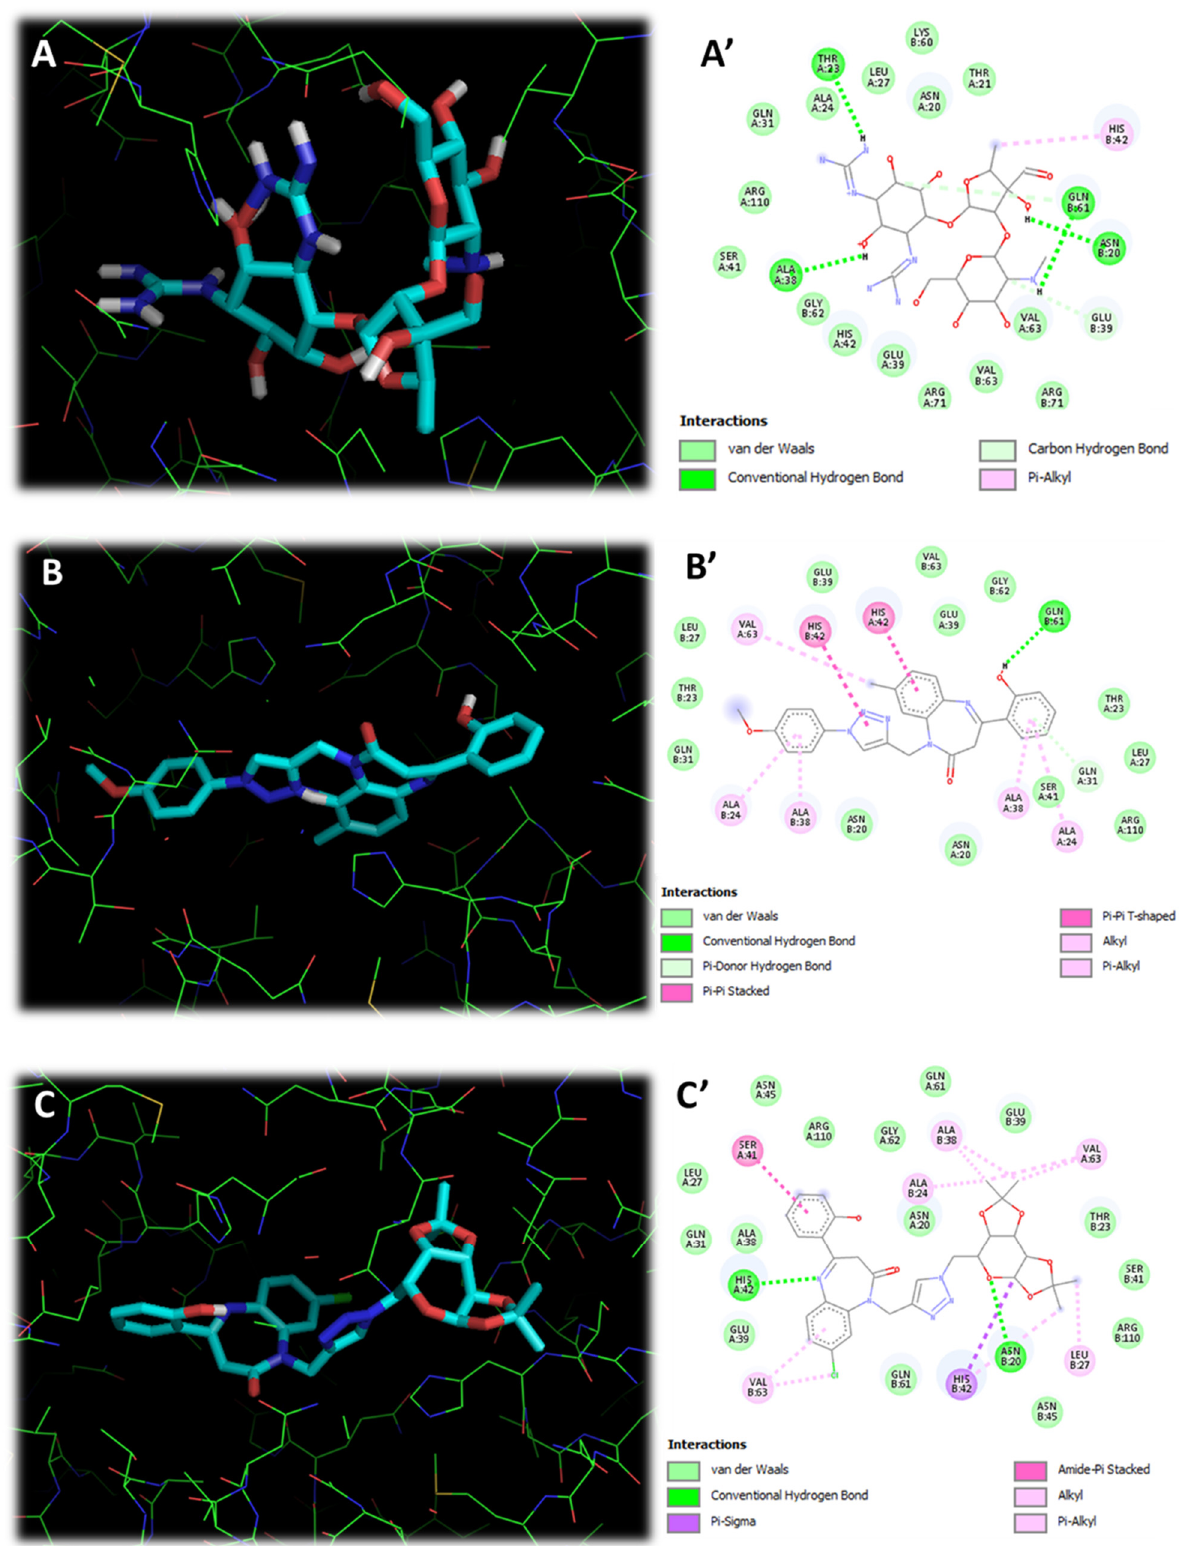
Figure 2. ( A ) is the 3D docking picture of reference ligand «Streptomycin» (the cyan one), ( A ′ ) is the 2D docking picture of reference ligand «Streptomycin», ( B ) is the 3D docking picture of the most active compound in series 1 (the cyan one), ( B ′ ) is the 2D docking picture of the most active compound in series 1, ( C ) is the 3D docking picture of the most active compound in series 2 (the cyan one), ( C ′ ) is the 2D docking picture of the most active compound in series 2.